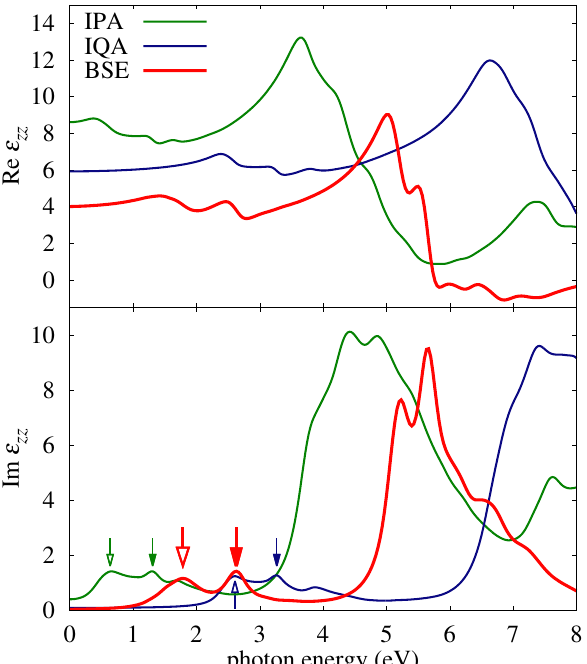
Figure 4. Real and imaginary part of the dielectric function for the EP-a calculated in the 2 × 2 × 2 supercell at three levels of theory: The independent-particle approximation using DFT + U (IPA, green), the independent-quasiparticle approximation with quasiparticle shifts from the G 0 W 0 approximation (IQA, blue), and the Bethe–Salpeter equation that additionally includes excitonic and local-field effects (BSE, red). Filled arrows mark the position of the absorption peak associated with the electron transition from the occupied upper defect state to the conduction bands, hollow arrows correspond to the transition from the valence bands to the unoccupied lower defect